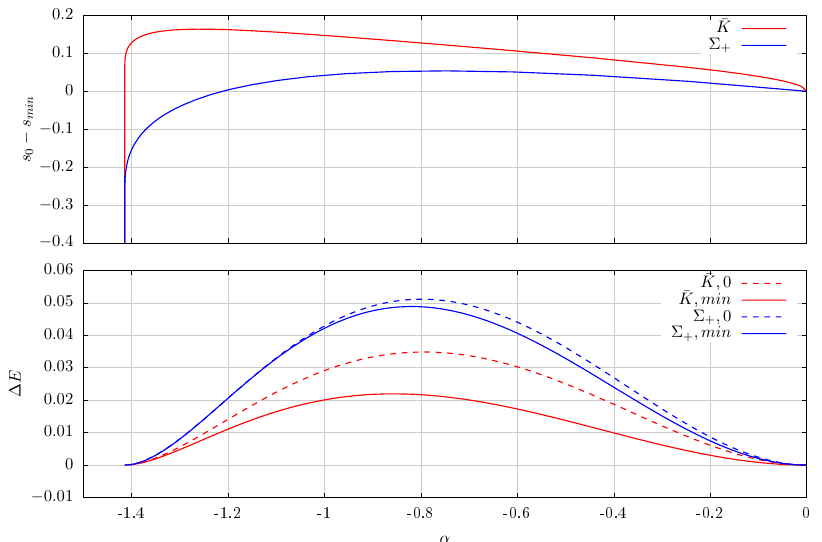
Figure 5 . Composite interpretation of the BPS solutions (antikink (cid:22) K , lump (cid:6) + ). Upper plot: discrepancy between separations obtained using the minimization of the energy ( BPS 2 ) functional and the zero of the BPS integral. Lower plot: energy excess of the solutions obtained from the approximations assuming trial functions, as compared to the real values ( E (cid:6) = 0 ; E (cid:22)